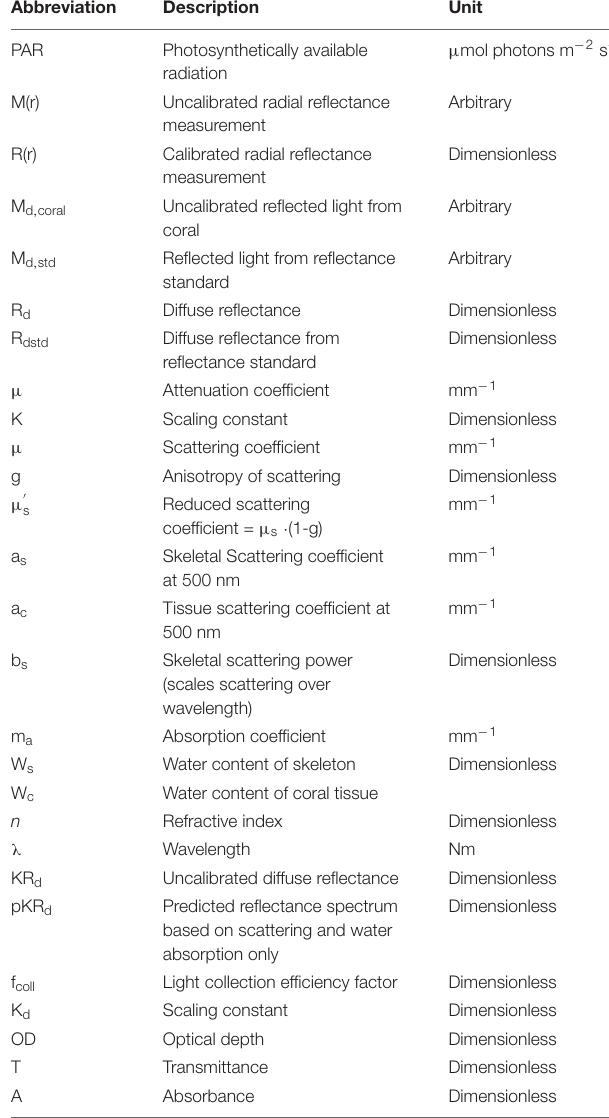
TABLE 1 | List of abbreviations and their